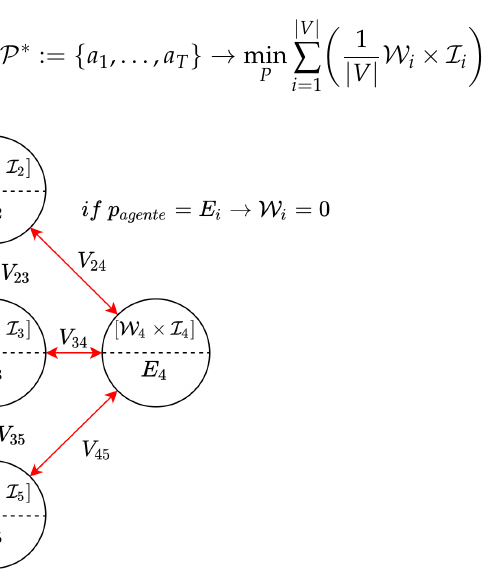
Figure 4. Example of graph G ( E , V , W ) for the Patrolling Problem. There is a metric assumption and every cell will hold its idleness W as the number of time steps since the last visit. In the beginning, the value of W in every cell is W max